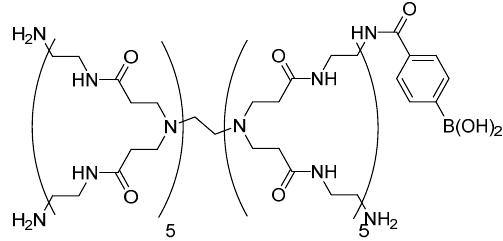
Figure 1. Chemical structure of PBA-PAMAM.